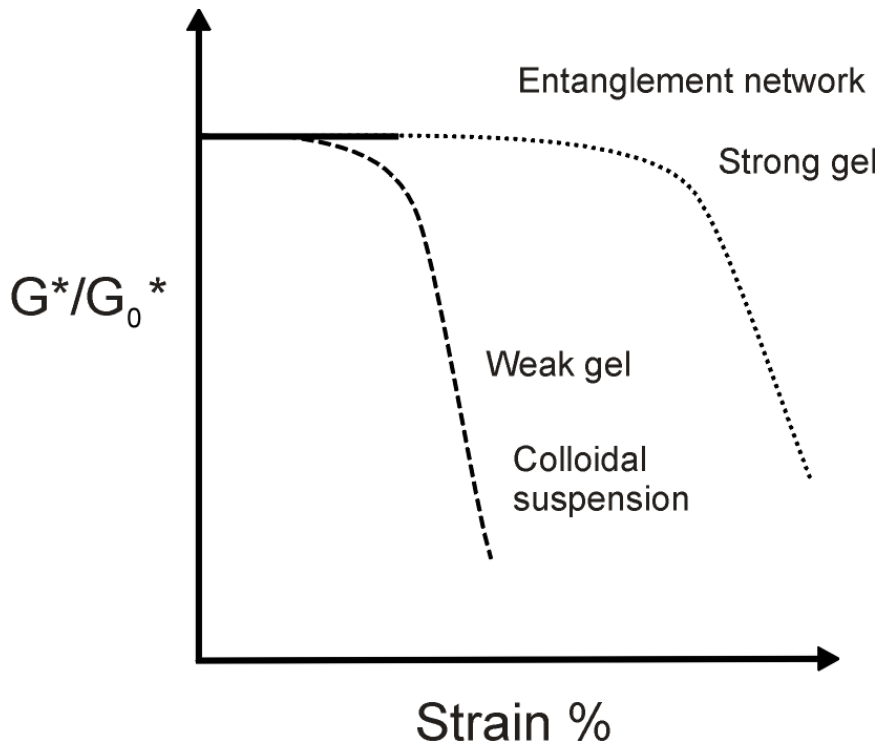
FIGURE 7. Strain dependence for different viscoelastic